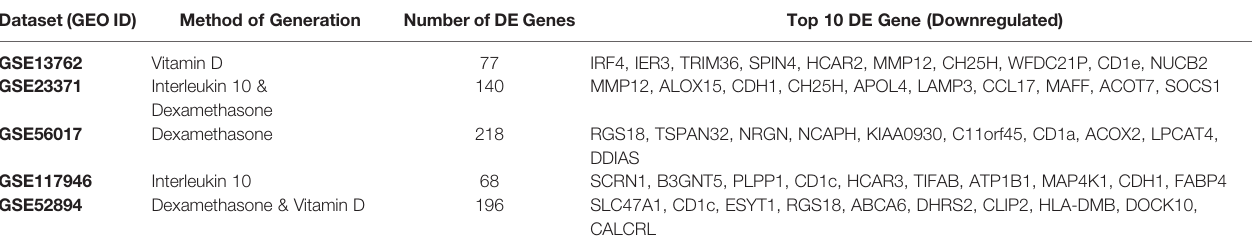
TABLE 2B | Top 10 differentially downregulated genes in tolDC. Dataset (GEO